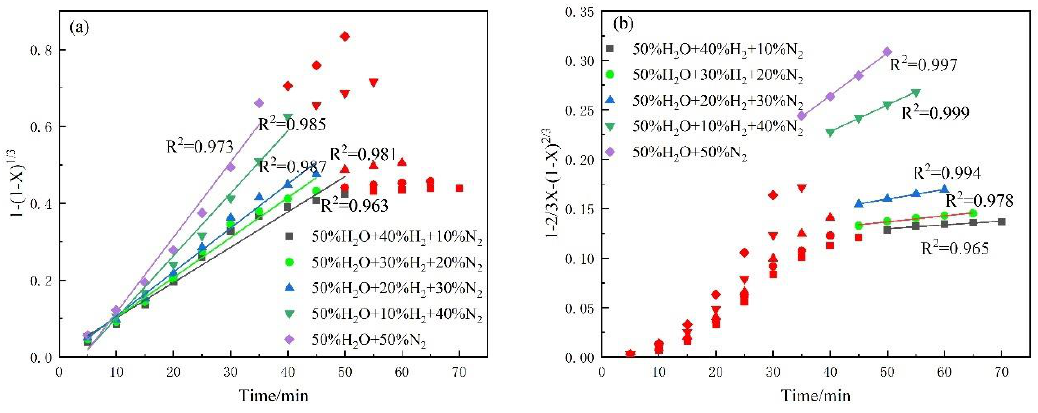
1 3 vs time and ( b ) 1 −